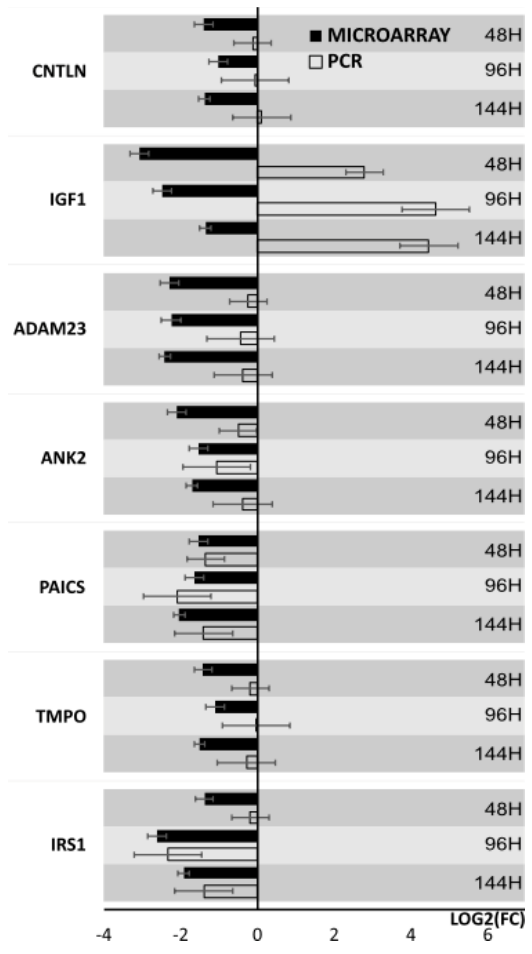
Figure 8. Functional interaction (FI) between 20 chosen differently expressed genes. In above figure “->“ stands for activating/catalyzing, “-” for FIs extracted from complexes or inputs, and “—” for predicted FIs. Results from microarray expression were confirmed by quantitative RT-qPCR on